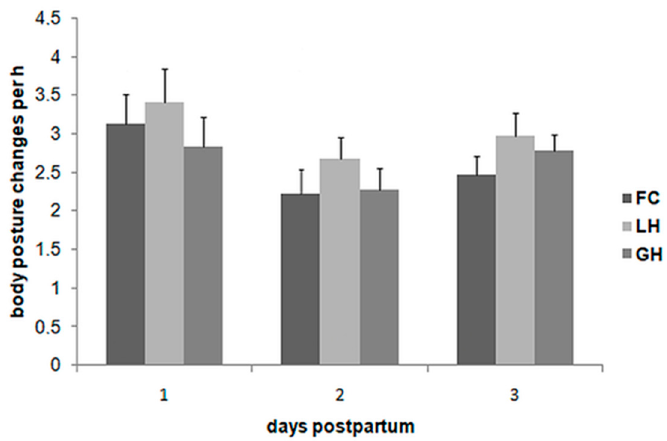
Figure 4. Mean body posture change frequencies (per sow and per hour) in the di ff erent farrowing systems (conventional pen with farrowing crate (FC), single loose housing pen (LH), single loose housing pen of the group housing system (GH)) on the three days